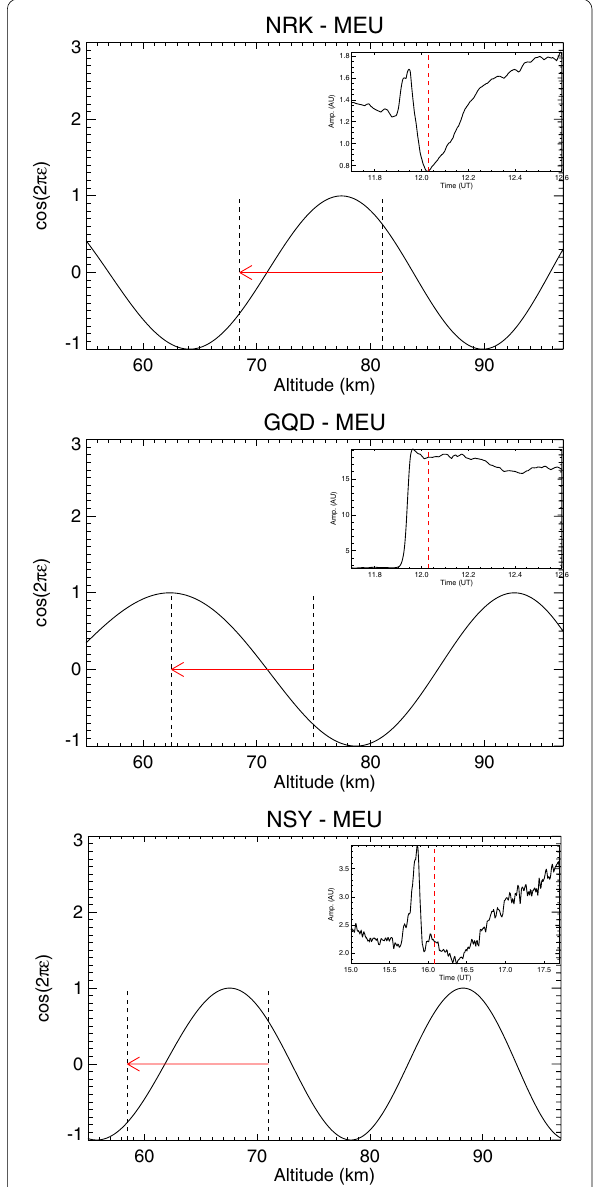
Fig. 3 Interference pattern for NRK (top panel) and GQD (middle panel) and NSY (bottom panel) vs. the reflection height. The sub-panels display the VLF time-profile for the X9.3 flare for NRK and GQD, and the X8.3 for NSY (since the transmitter was off for the biggest flare). Example of reflection height variation during the flare is indicated with the vertical dashed lines, while the arrow indicates the direction followed during the flare rise